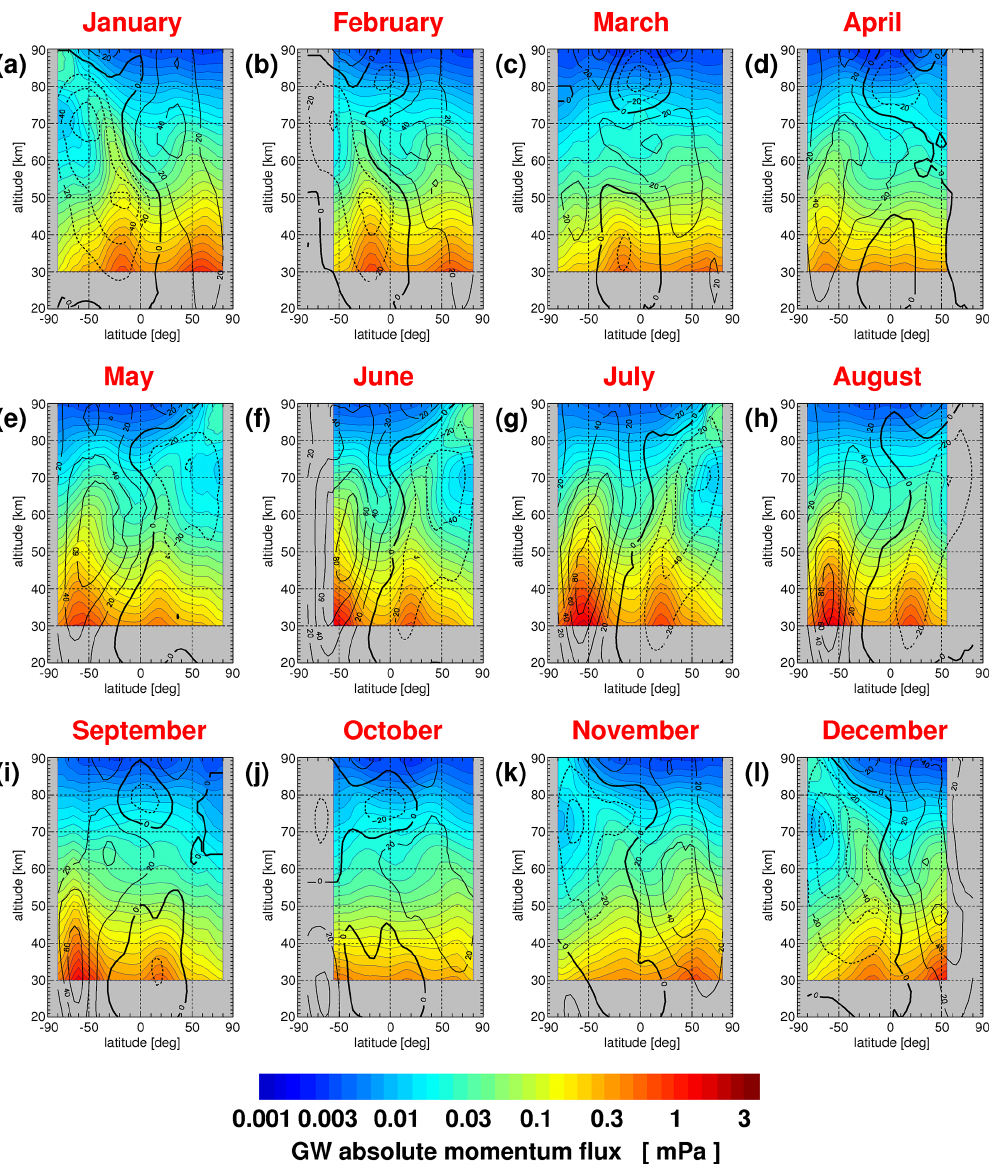
Figure 15. Multiyear mean zonal mean distributions of SABER median absolute gravity wave (GW) momentum fluxes for each calendar month. The averaging period is from January 2002 until October 2020. The plotted contour lines are zonal winds taken from the SPARC climatology of zonal winds (Swinbank and Ortland, 2003; Randel et al., 2002,